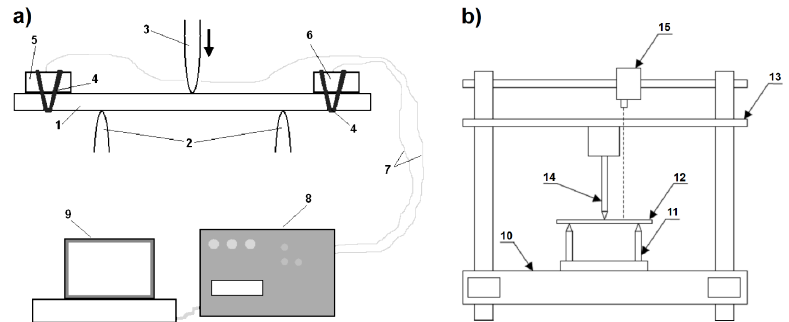
Figure 1. Scheme of the measuring devices used for signal registration during 3 ‐ point bending tests: ( a ) Acoustic emission signal registration; 1, sample; 2, supports; 3, loading bar; 4, elastic fixing welts; 5, Acoustic Sensor I; 6, Acoustic Sensor II; 7, wires; 8, Vallen registrator; 9, computer; ( b ) Vibrations signal registration; 10, machine frame; 11, supports; 12, sample; 13, movable traverse with a force ‐ measuring head; 14, loading bar; 15, laser vibrometer.